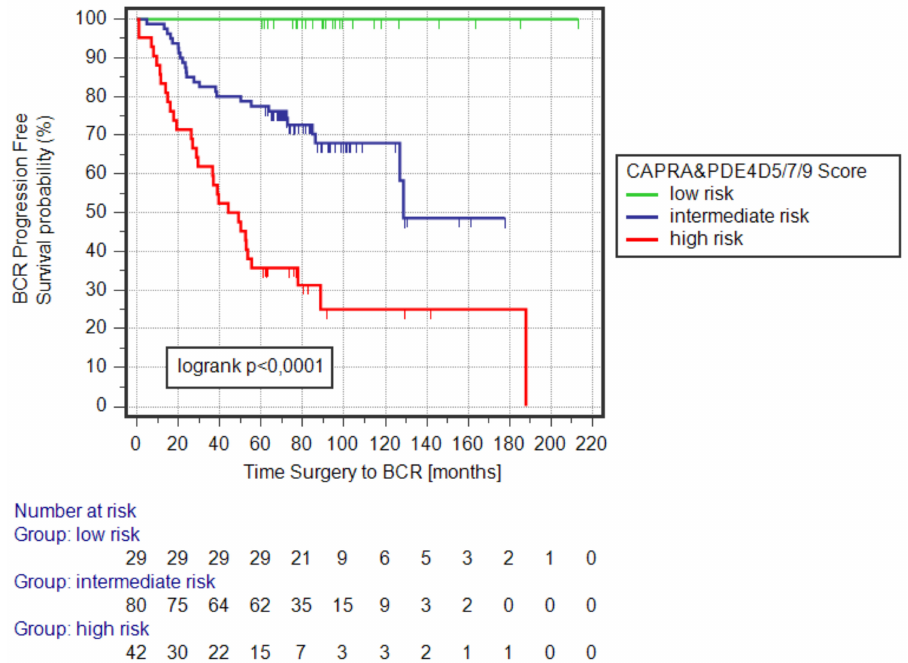
Figure 1. Kaplan–Meier survival analysis of the CAPRA&PDE4D5/7/9_ BCR regression model.